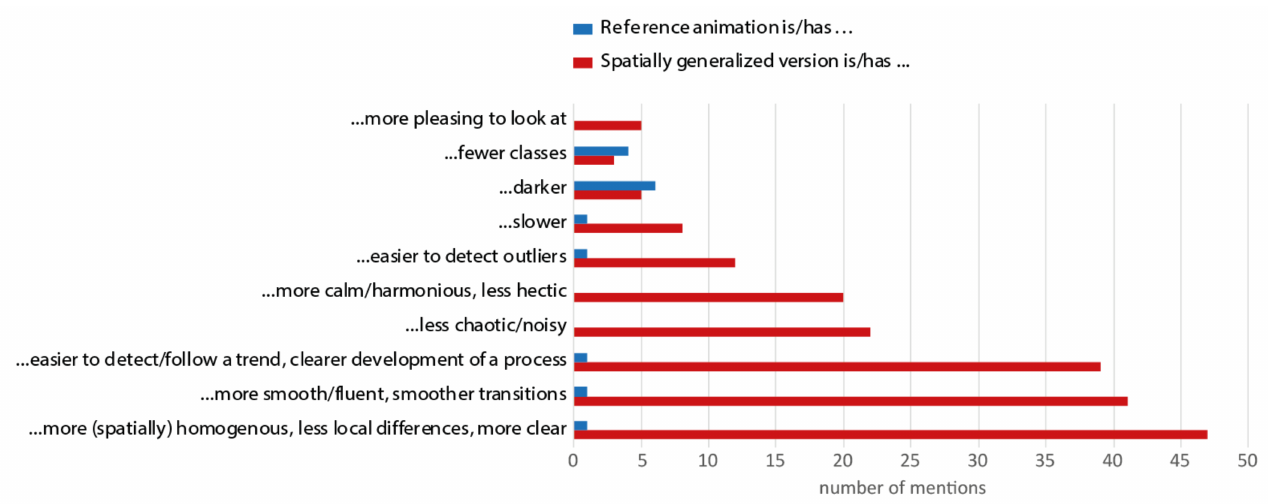
Figure 15. Number of comparative mentions in verbal descriptions of differences between the reference animation and its spatially generalized counterpart of Stimulus 4. Classification was done semantically, e.g., “Version A is more chaotic than version B” is classified as “Spatially generalized version (B) is less chaotic”. In addition to these 217 comparative statements, 25 statements like “In version B the bright yellow seems to move farther up north” could not be attributed in a comparative way and were